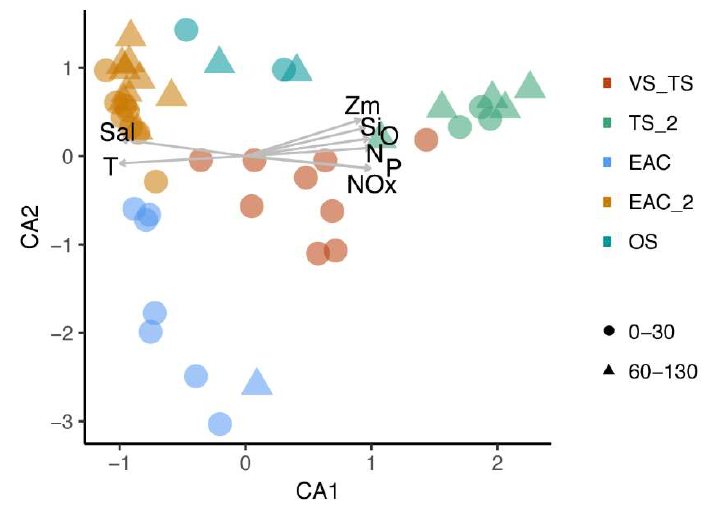
Figure 7. Canonical correspondence analysis (Vegan) plot of the main (1770) virus contigs distribution for the different sites. Samples are colour coded based on cluster assigned with hierarchical cluster analysis (SIMPROF). Salinity—Sal, temperature—T, mix layer depth—Zm, silicate—Si, oxygen—O, nitrite/nitrate—NOx, nitrite—N, phosphate—P.